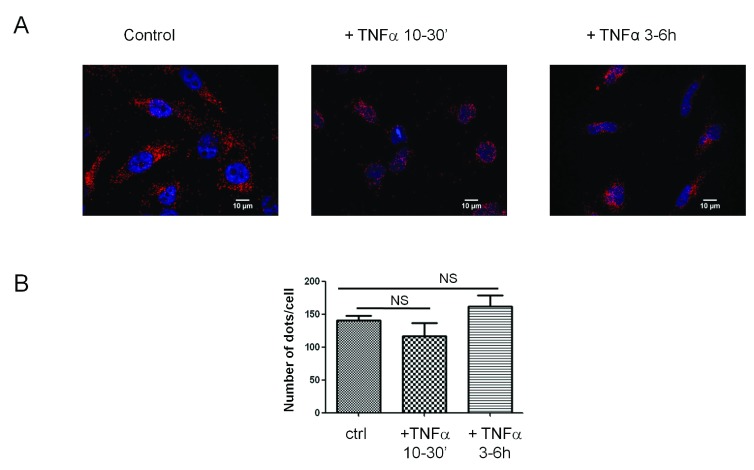
Keratin 8-F508del-CFTR proximity in HeLa cells.
A. Differential interaction between K8 and CFTR in cells treated with TNFα (50ng/ml) for varied durations. DNA proximity ligation assay of K8 and CFTR in HeLa cells transfected with F508del-CFTR, scale bar = 10 µm.
B. Number of dots corresponding for proteins pairs, Keratin 8 –F508del-CFTR, per cell. NS, not significant.